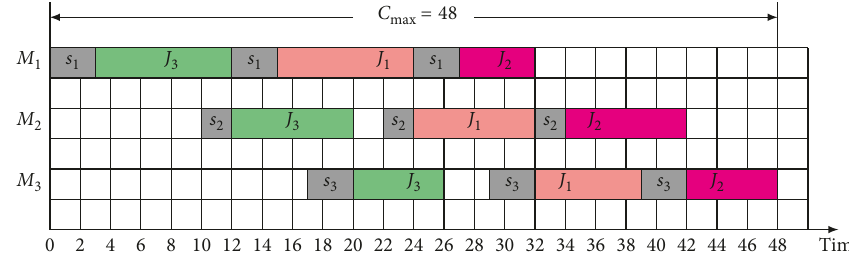
Figure 2: Gantt chart for three jobs in three